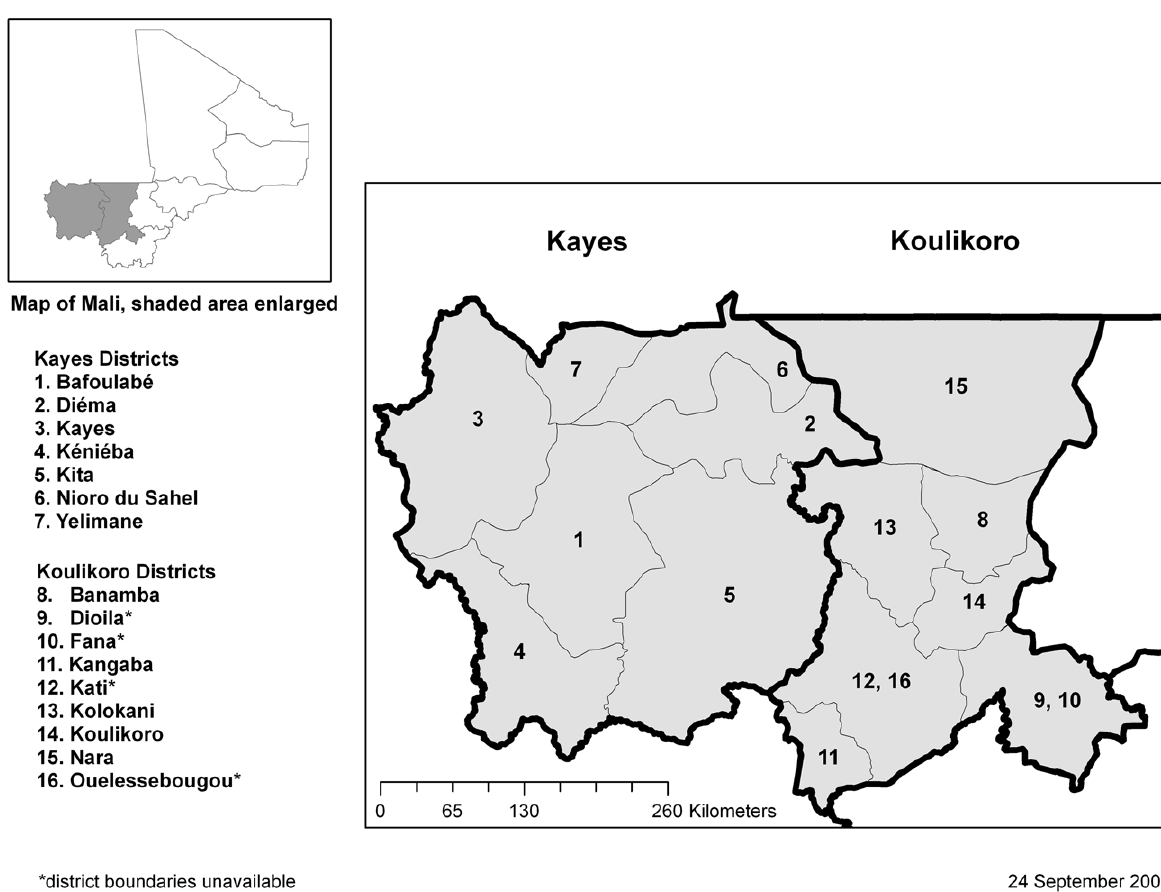
Figure 1. Regions of Kayes and Koulikoro, Mali.